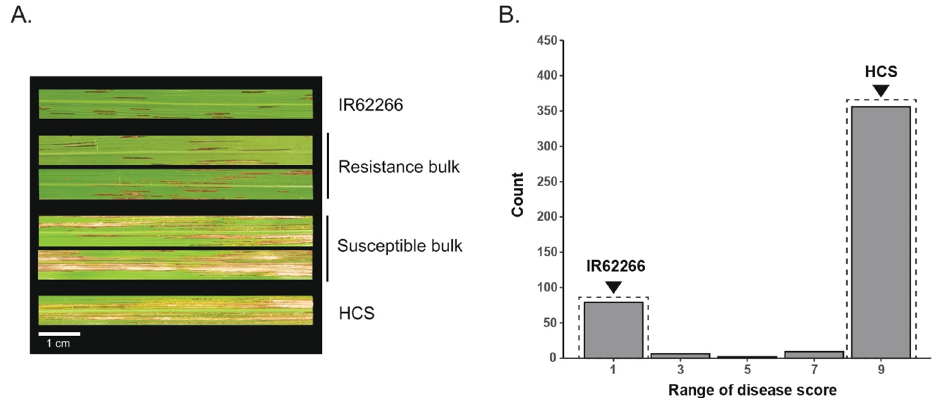
Figure 1. Bacterial leaf streak (BLS) phenotype in parental lines and F 2 plants. ( A ) The BLS symptom in the resistant parent (IR62266) and susceptible parent (HCS), and in the representative F 2 lines in the resistant bulk and susceptible bulk. ( B ) Distribution of BLS scores in 433 F 2 lines. The scores of the resistant parent and susceptible parent are indicated by a triangle. The dashed rectangle indicates the plants that were selected to produce the resistant bulk and susceptible bulk.